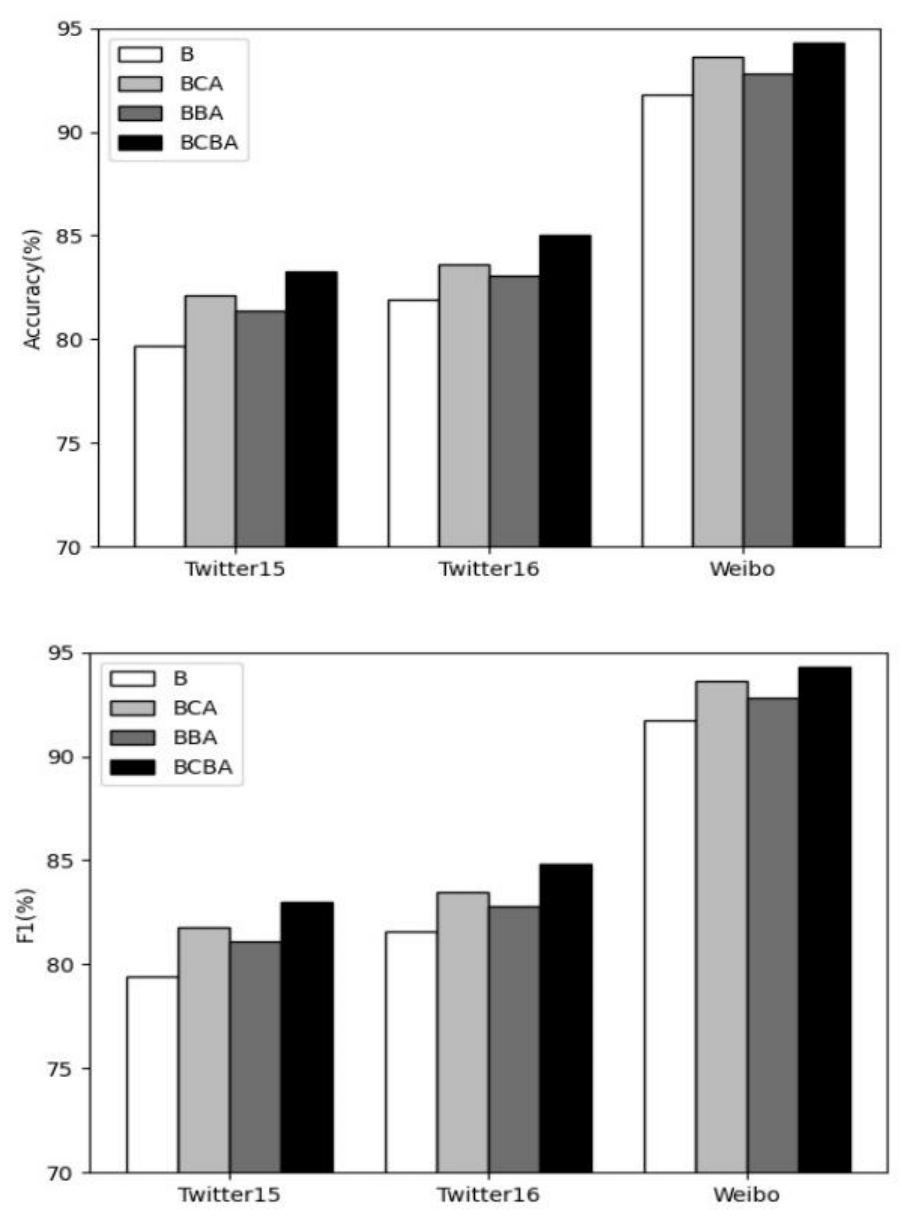
Figure 5. Results of semantic feature extraction ablation.